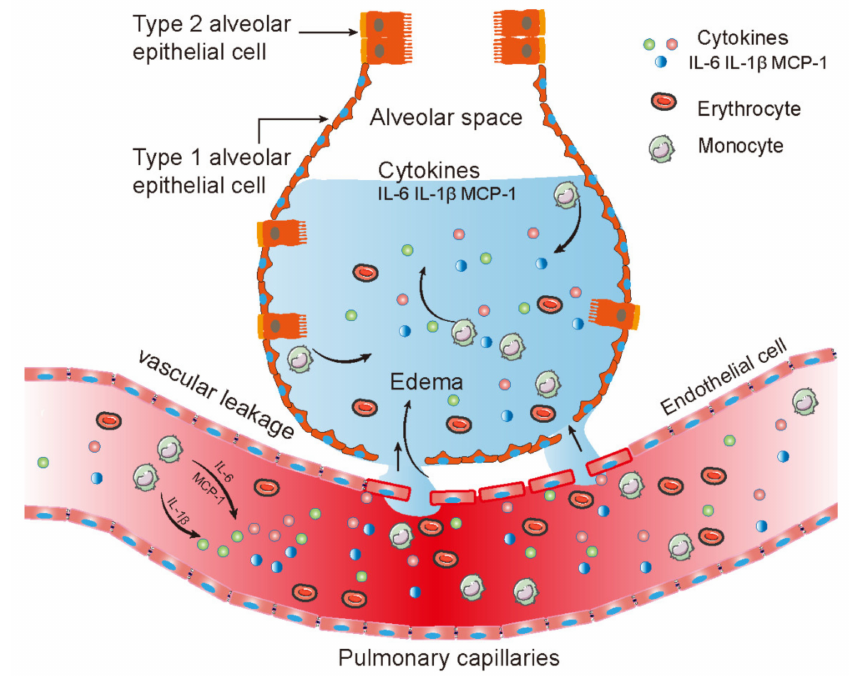
Figure 7. A hypothetical schematic of the